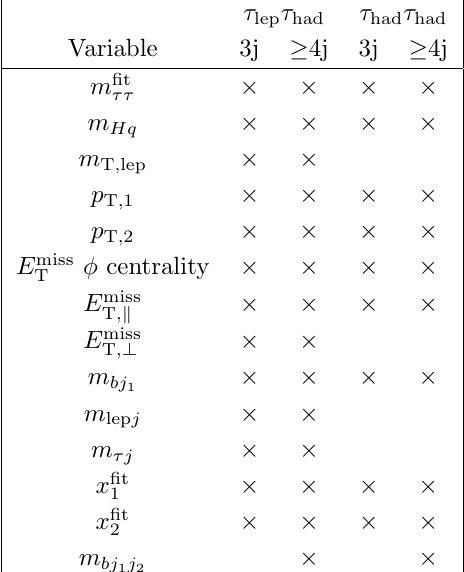
Table 2 . tqH ( (cid:28)(cid:28) ) search: discriminating variables used in the training of the BDT for each search region (denoted by (cid:2) ). The description of each variable is provided in the text. the transverse mass calculated from the lepton and ~p miss